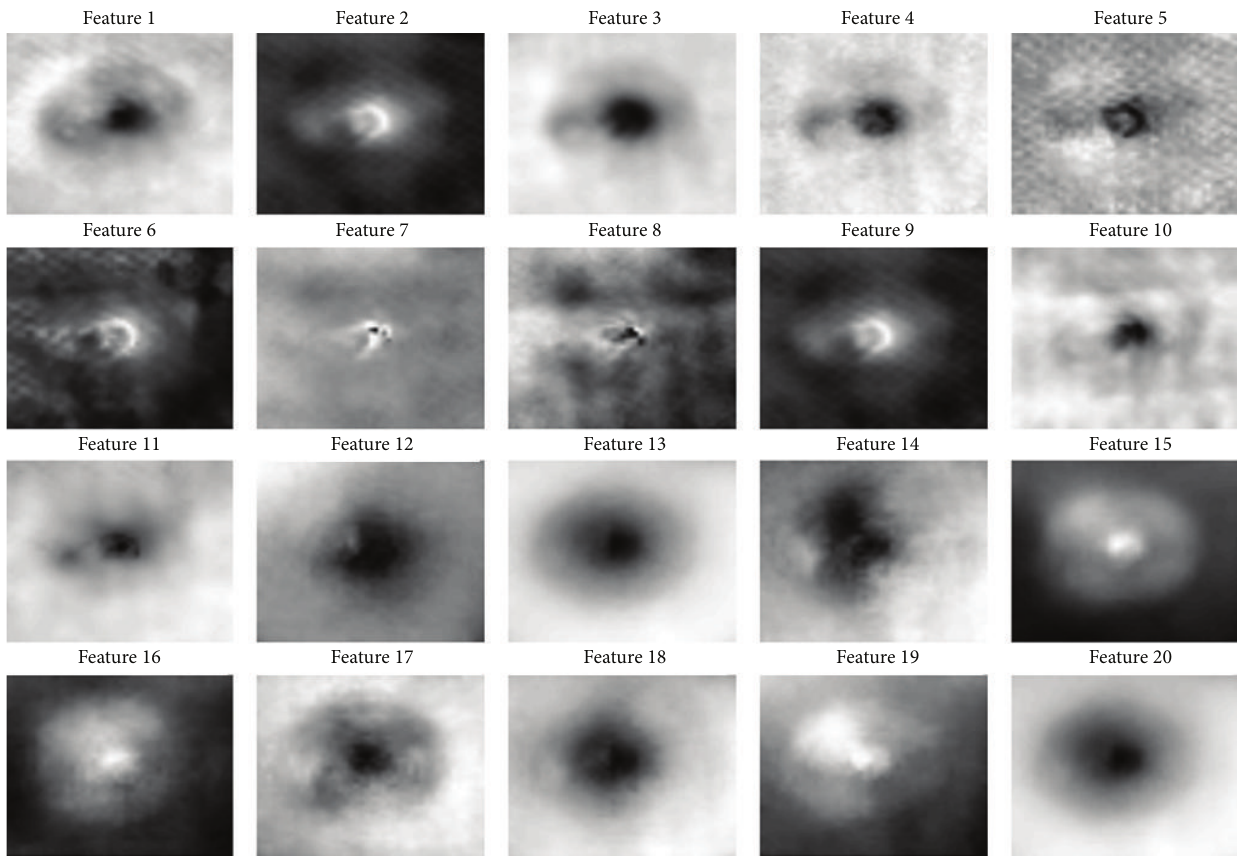
Figure 13: Results of the data registration process carried out for features vector obtained for sample impacted by